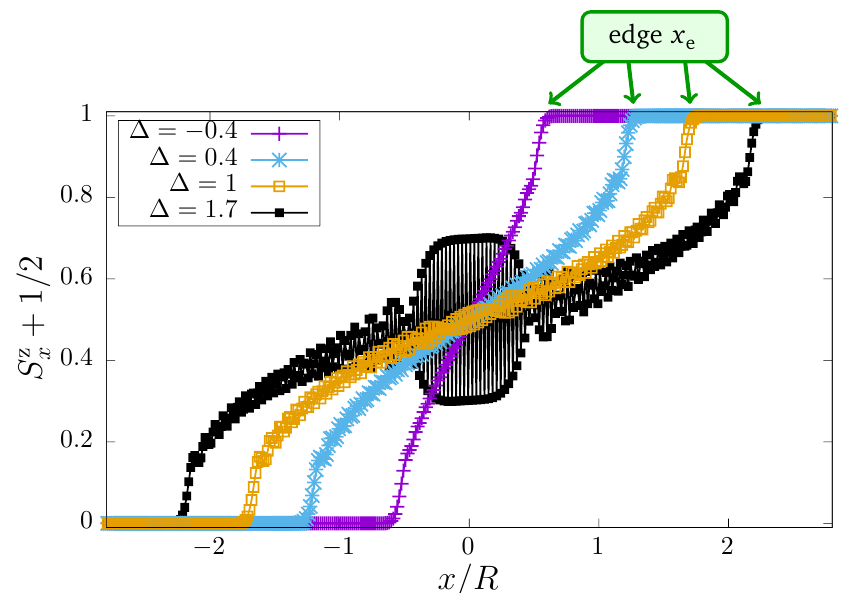
Figure 2: Numerical density profile for R = 64, and a = 0.1, obtained using DMRG. The data is shown for four different values of ∆ . In practice we use a system of total size L = 512, which is significantly larger than the effective size of the system 2 x , outside of which the wave function is fully polarized. The central region with e antiferromagnetic order is a specificity of ∆ > 1, as mentionned in the text. In